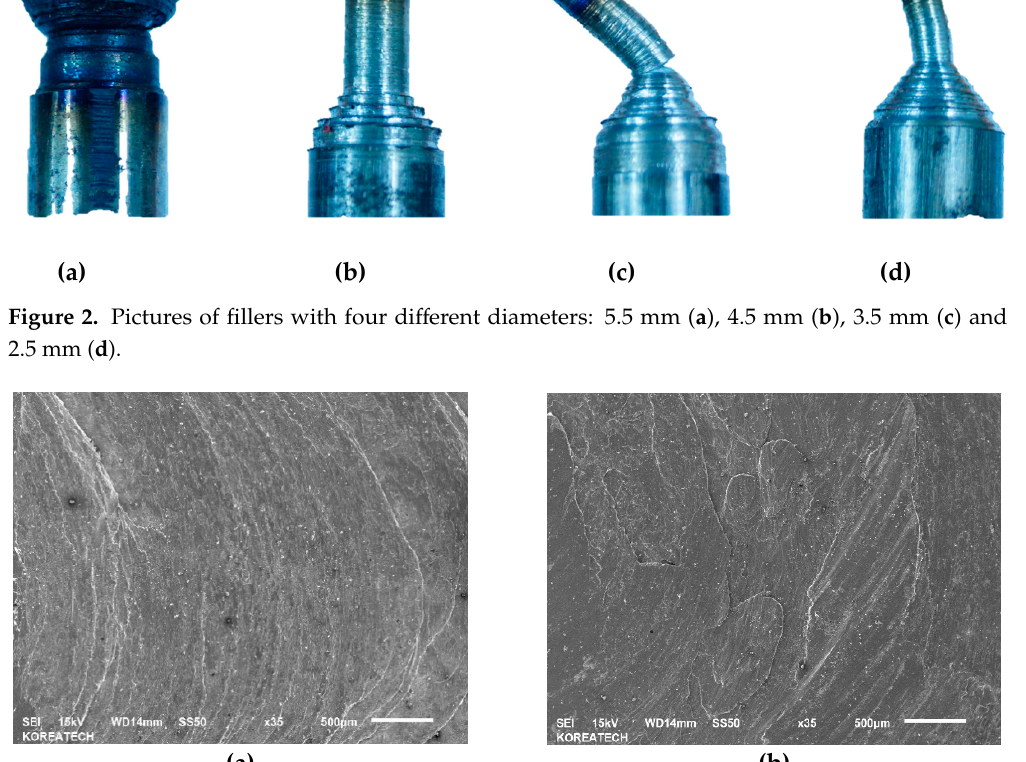
Figure 3. SEM images of the top surface of ( a ) single and ( b ) double layers.